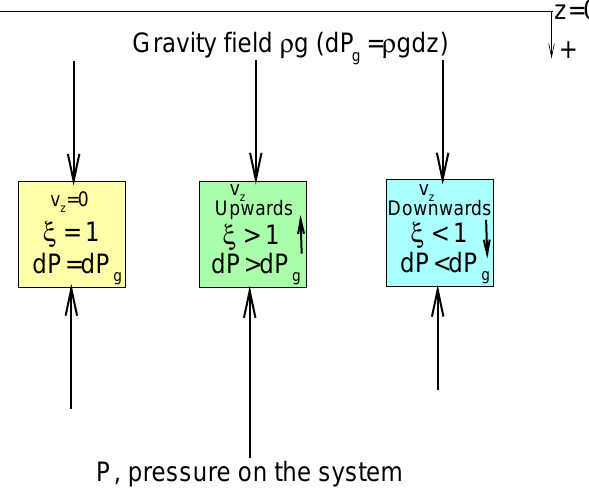
Figure 1. Vertical pressure components acting on the system. Ver- tical motion is the result of the difference between the gravitational pressure force P g and the vertical pressure force P acting on the